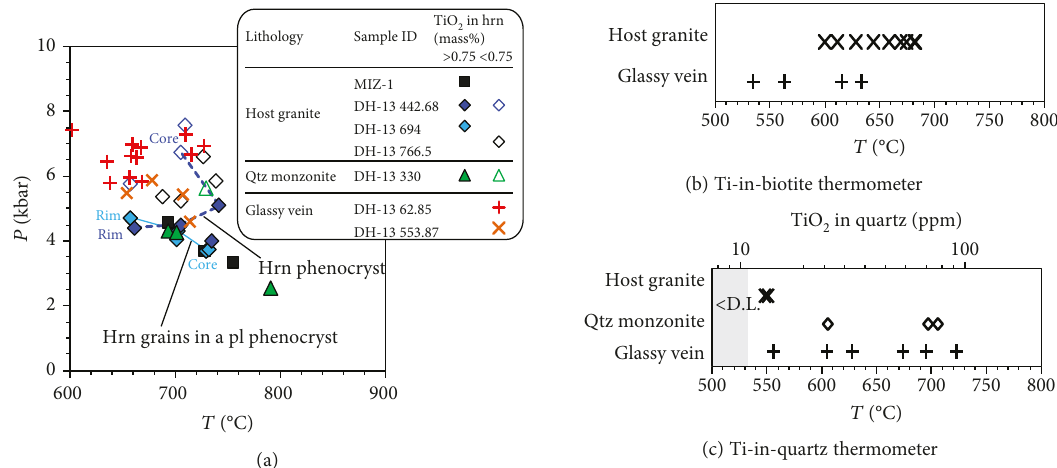
Figure 7: Temperature and pressure estimation. (a) Temperature and pressure estimated using an amphibole-plagioclase thermometer [41] and Al-in-hornblende barometer [42]. (b) Temperature estimated using a Ti-in-biotite thermometer. (c) Temperature estimated using a Ti-in-quartz